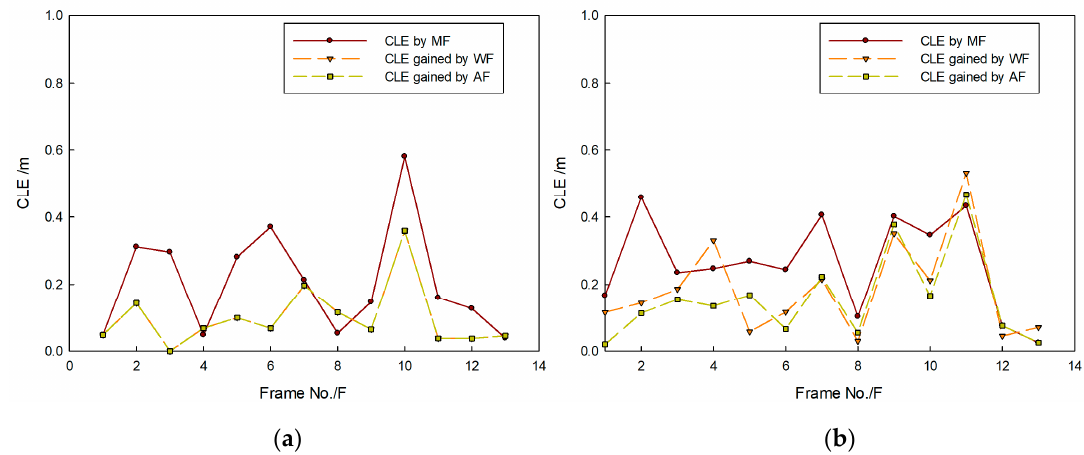
Figure 16. CLE gained by different fusion methods: results of ( a ) first target and ( b ) second target.